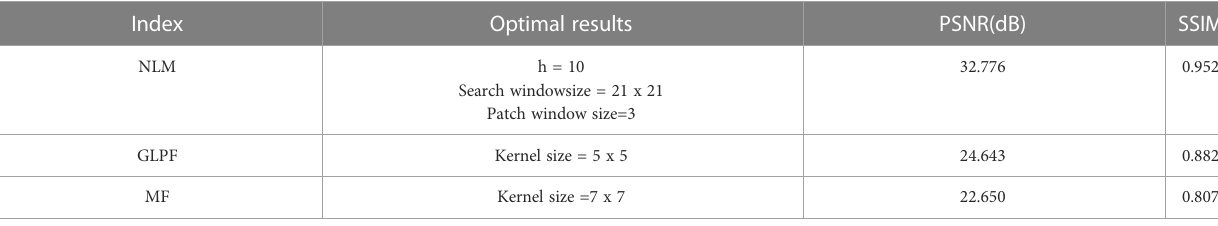
TABLE 2 The denoising results of the MRI images of the cotton root